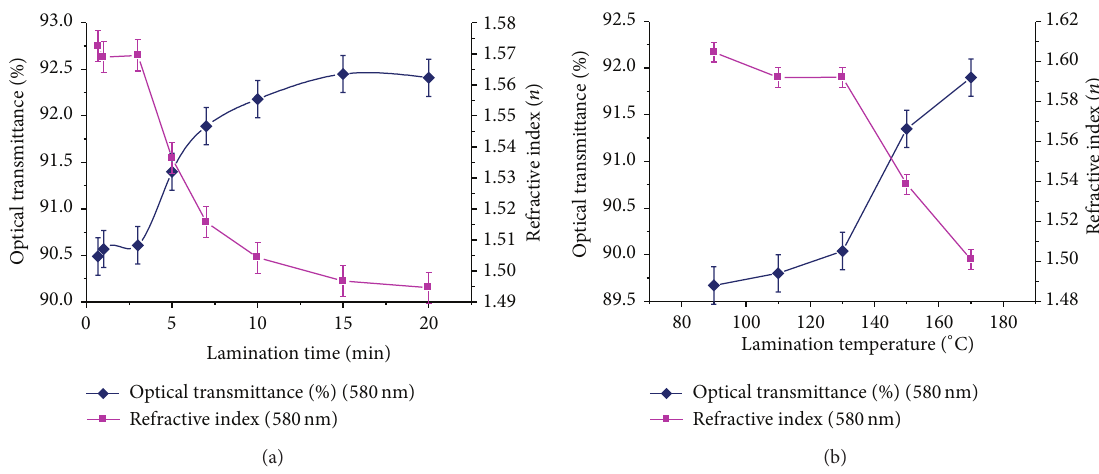
Figure 8: (a) The refractive index and optical transmittance of EVA versus the lamination time at a fixed lamination temperature of 150 ∘ C. (b) The refractive index and optical transmittance of EVA as functions of the lamination temperature for a fixed lamination time of 7 minutes.